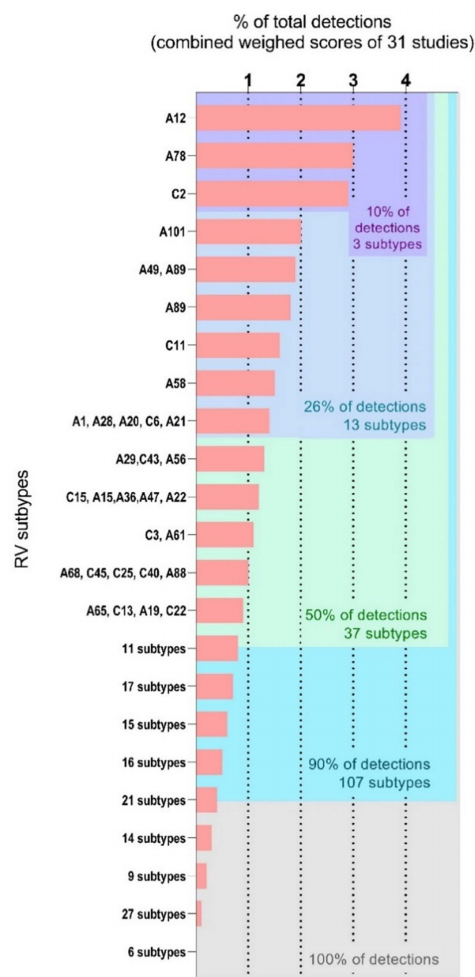
Figure 1. RV subtype contribution to total detections in a panel of 31 clinical studies typing RVs. RV subtypes are shown ranked highest to lowest for their contribution of total RV detections in the panel of 20 studies. When several subtypes are listed together, they each contribute to the same percentage of total